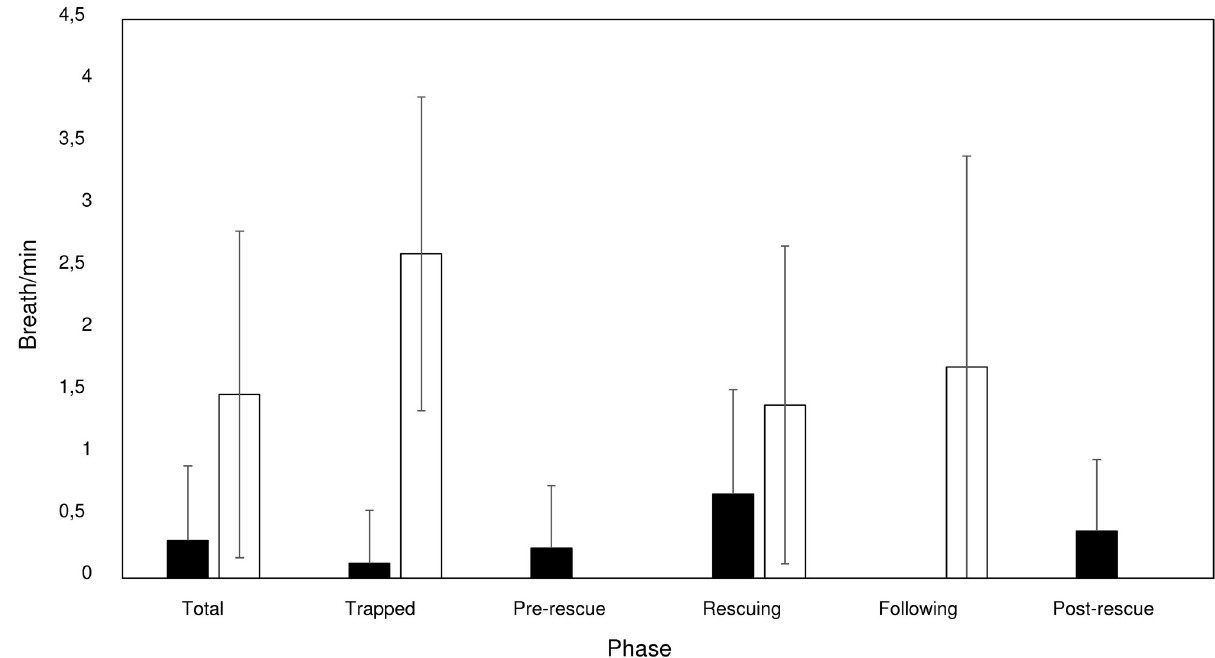
Fig 6. Mean breath/minute in each phase comparison. First whale (black) and second whale